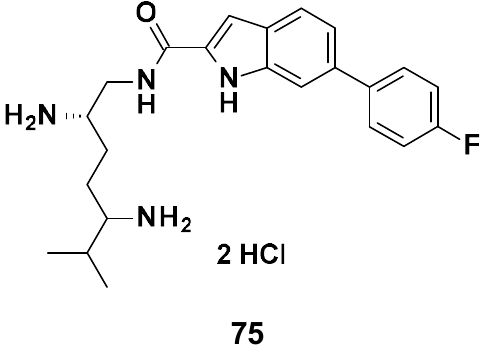
Figure 12. Structure of compound 75 , evaluated in